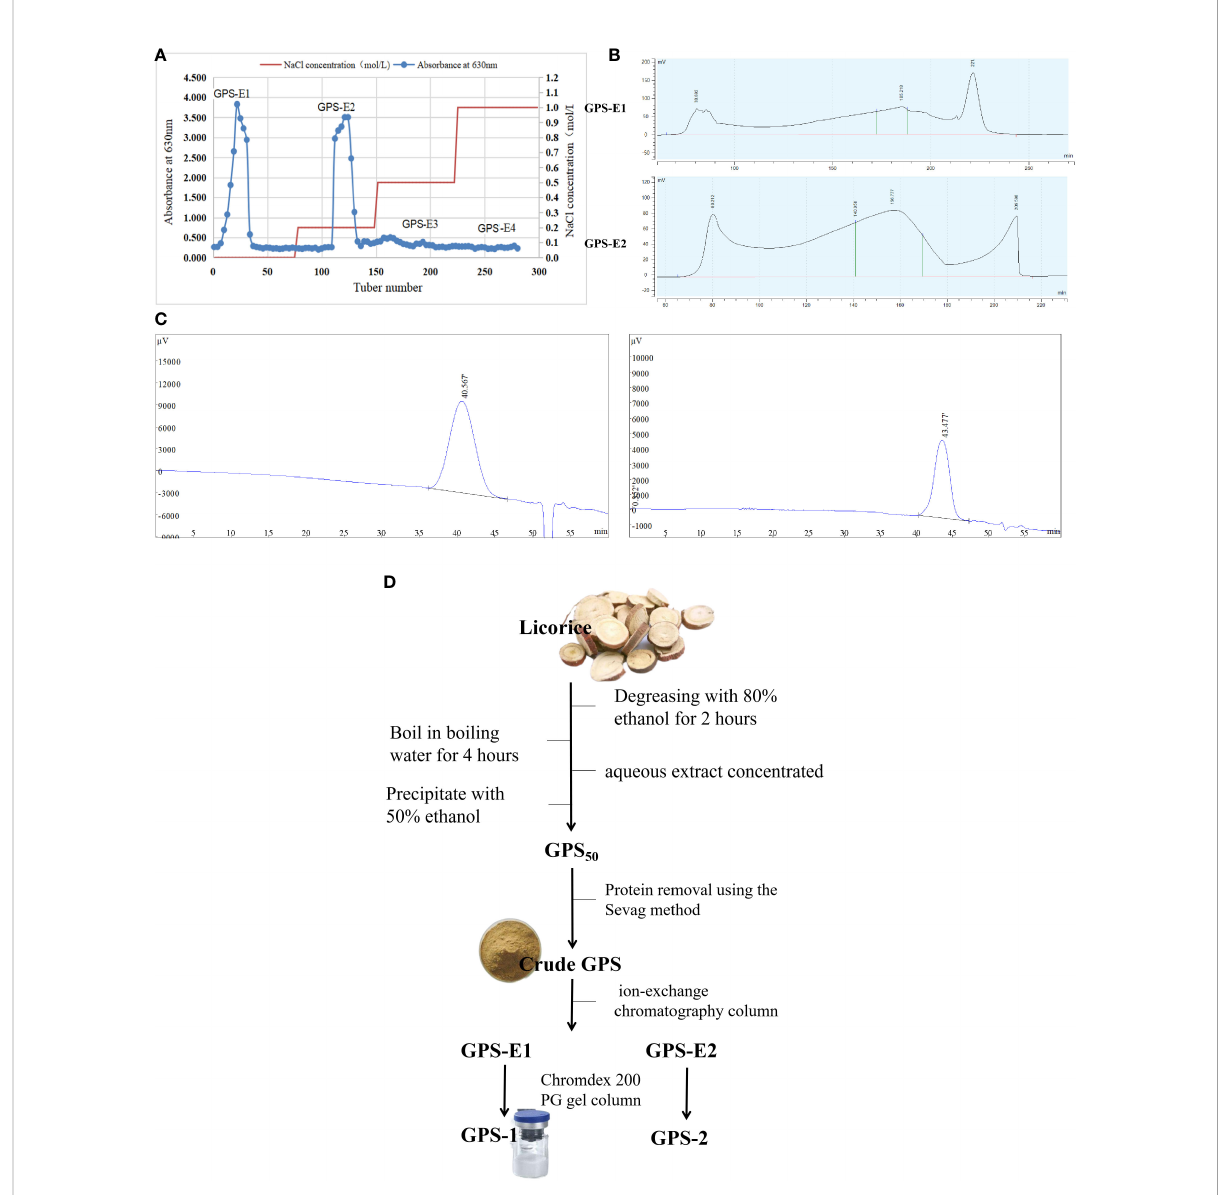
FIGURE 1 (A) Elution pro fi le of GPS50 ion-exchange column chromatography. (B) Elution pro fi les of samples GPS-E1 and GPS-E2 gel fi ltration column chromatography (C) The HPGPC chromatogram of the GPS-1 (left) and GPS-2 (right). (D) The speci fi c fl ow chart of GPS-1